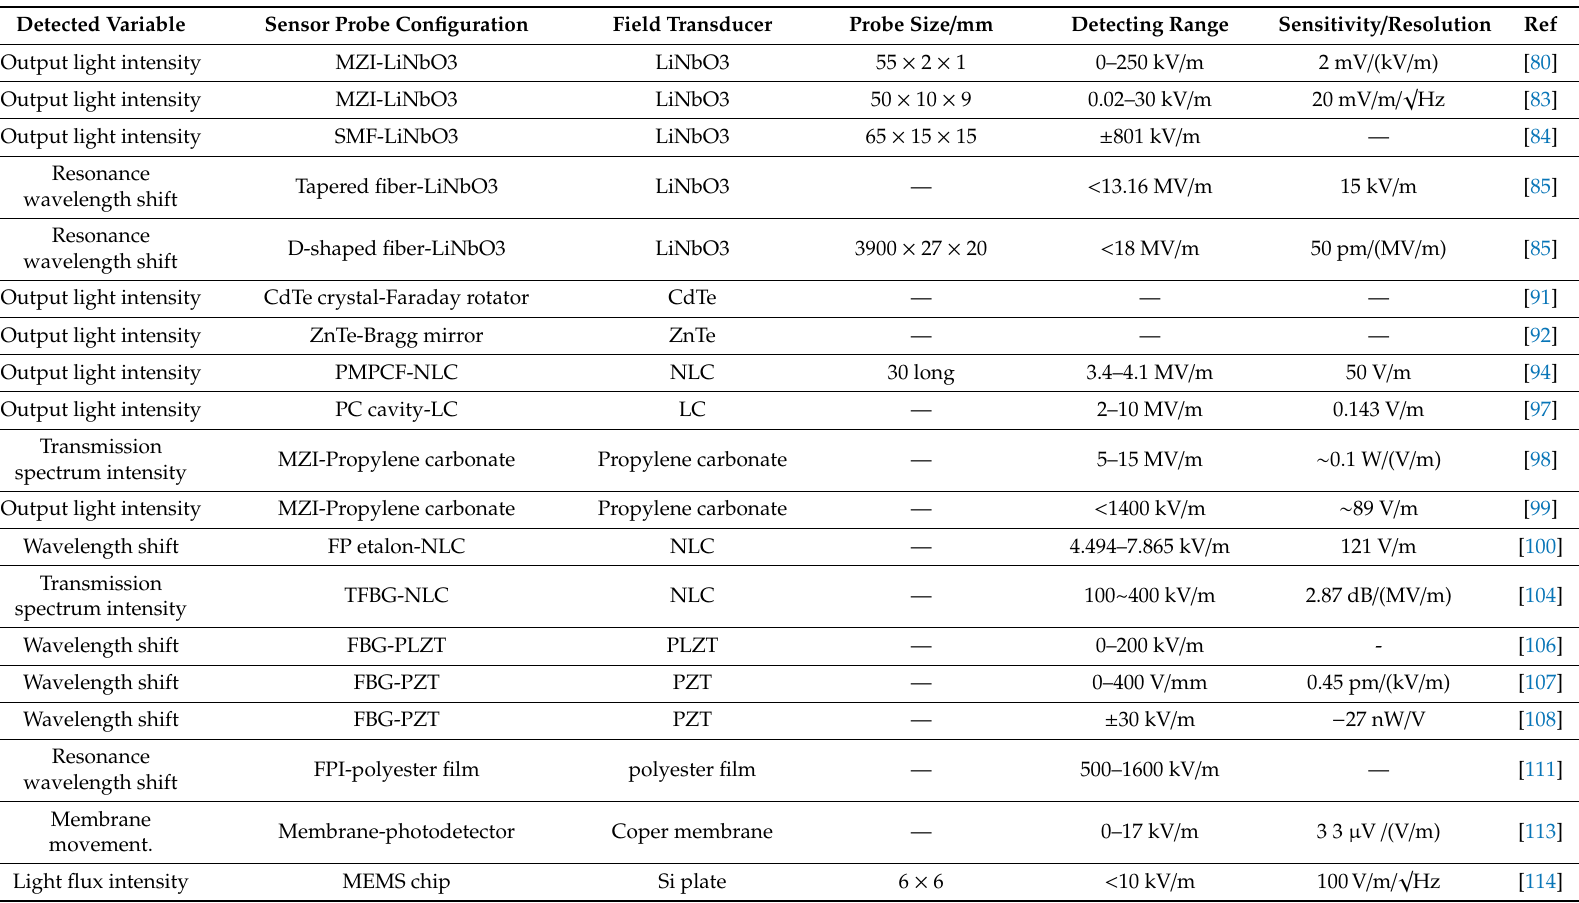
Table A2. Performance parameters of optical fiber electric field